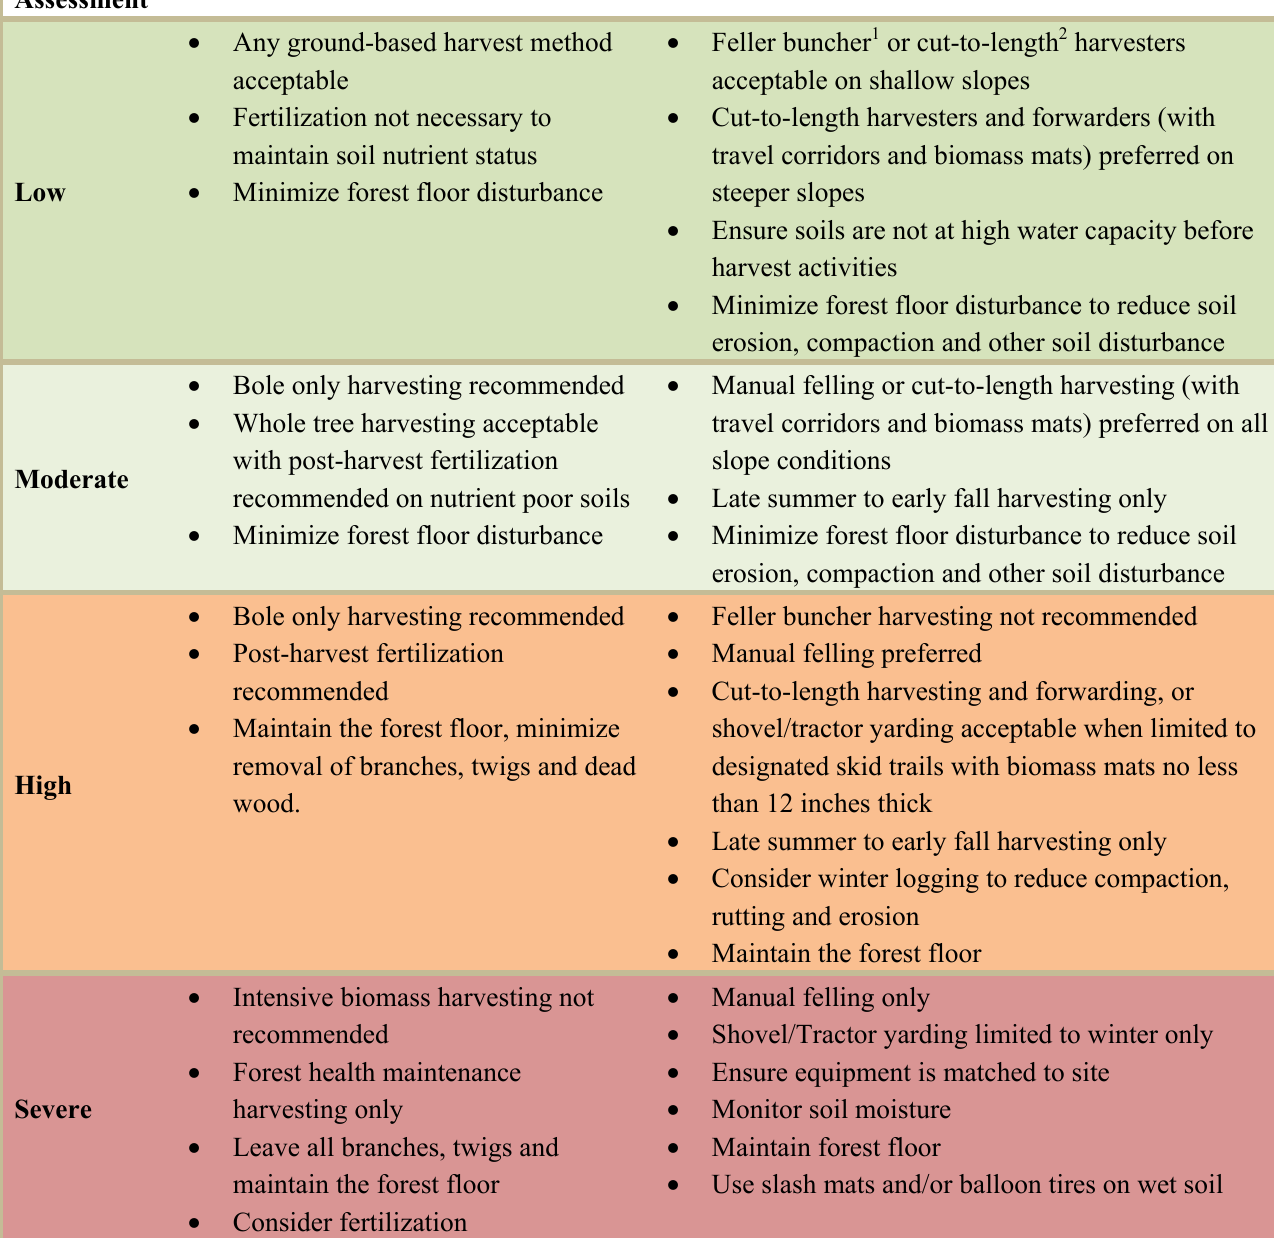
Table 4. Best management practices for maintaining soil productivity during ground-based biomass harvest activities by risk assessment class in the ID612 survey area of the Northern Rockies ecoregion, USA. Table colors intended to reflect risk rating color scheme in Figure